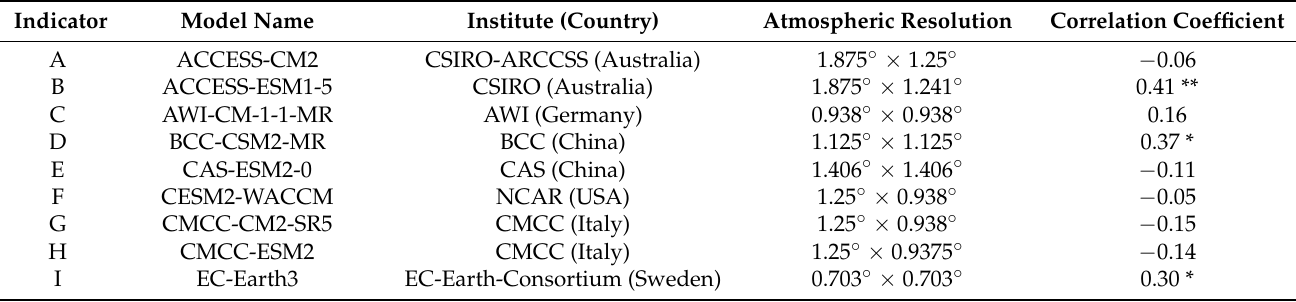
Table 2. Information of CMIP6 models used in this study and the correlation between model data and observation data.